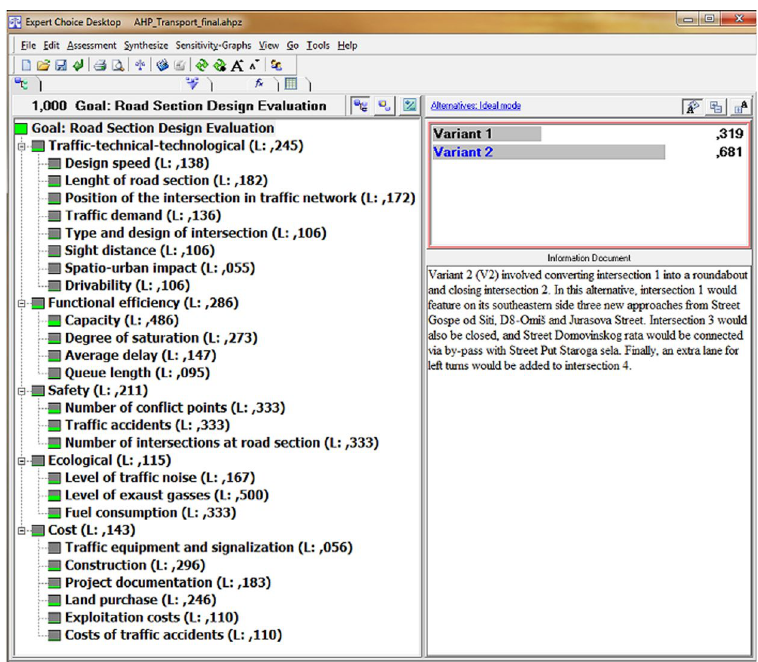
Fig. 4. Weighting factors for criteria and sub-criteria in the AHP